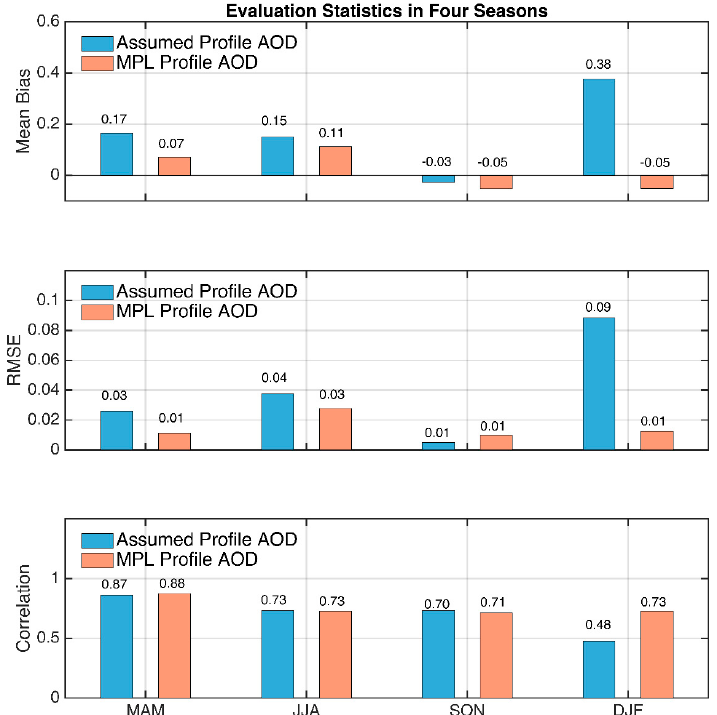
Figure 14. Comparison of the mean bias (upper panel), RMSE (middle panel) and the correlation (bottom panel) between the retrieval using the exponential profile (blue) and the MPL-retrieved aerosol profile (orange) for the four seasons.